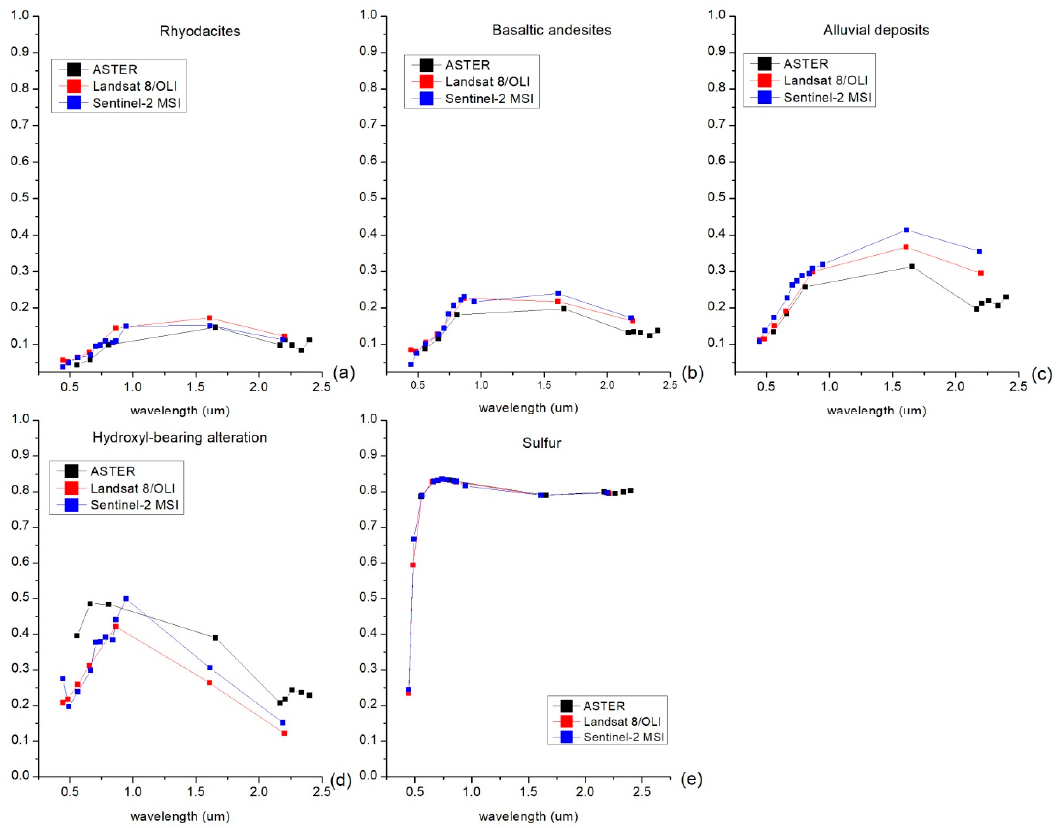
Figure 7. Comparison of the spectral signatures of each endmember in the spectral bands of each satellite sensor: ( a ) rhyodacites, ( b ) basaltic andesites, ( c ) alluvial deposits, ( d ) hydroxyl-bearing